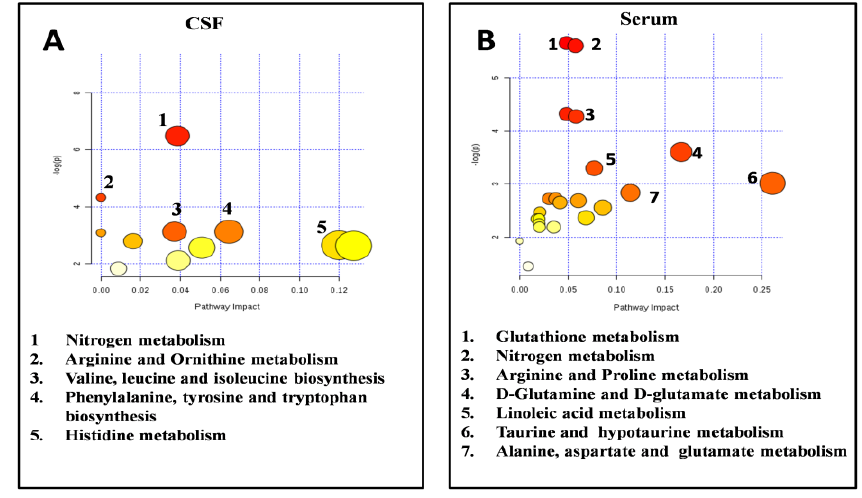
Figure 5. Pathways analysis. Pathways analysis of the most discriminant metabolites passing the Holm–Bonferroni correction in CSF and serum. ( A ) Most altered pathways between RR and PP patients in CSF samples: nitrogen metabolism, arginine and ornithine metabolism, branched chain amino acid (BCAAs) biosynthesis, phenylalanine, tyrosine and tryptophan biosynthesis and histidine metabolism. ( B ) Most altered pathways between RR and PP patients in serum samples: glutathione metabolism, nitrogen metabolism, arginine and proline metabolism, glutamine and glutamate metabolism, linoleic acid metabolism, taurine and hypotaurine metabolism and, finally, alanine, aspartate, and glutamate metabolism.